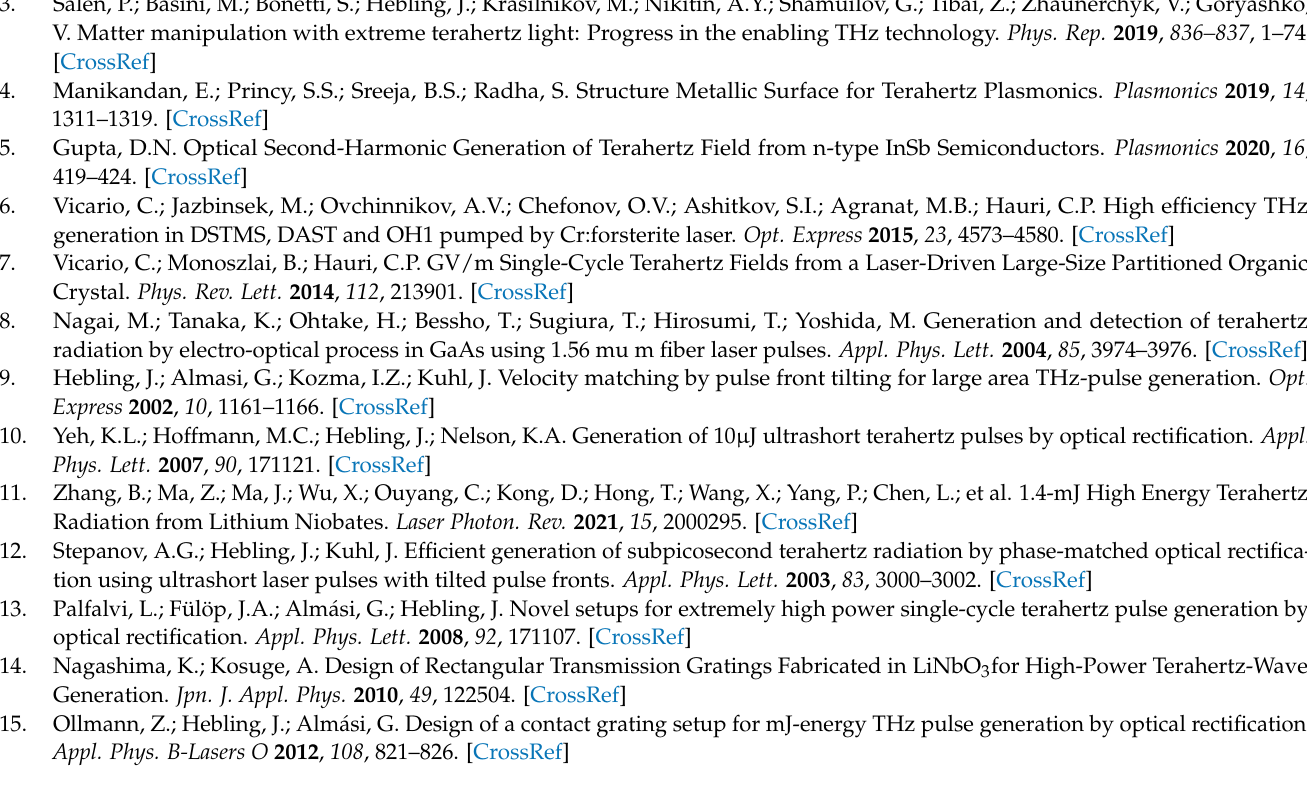
Figure A2. ( a ) Calculated GaAs diffraction efficiency (DE) as a function of groove depth h and filling factor f , with NOA ARC and ( b ) diffraction efficiency versus NOA ARC thickness h 3 , at λ p = 3.0 µ m, d = 2.4 µ m, and 3 THz phase-matching